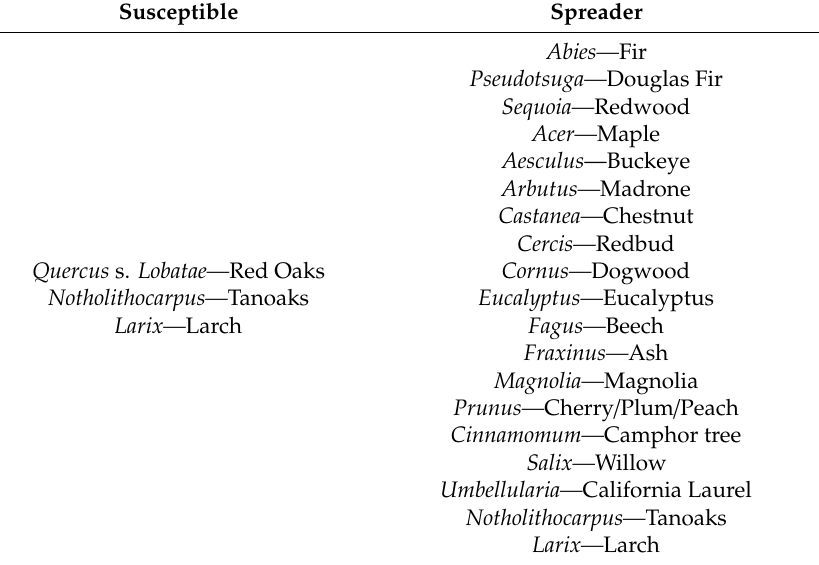
Table 1. Tree genera and subgenera known to include suitable hosts for P. ramorum. “Susceptible” genera are those which are frequently killed by P. ramorum, while “spreader” genera are those that can be infected and pass on the pathogen. Some genera are in both